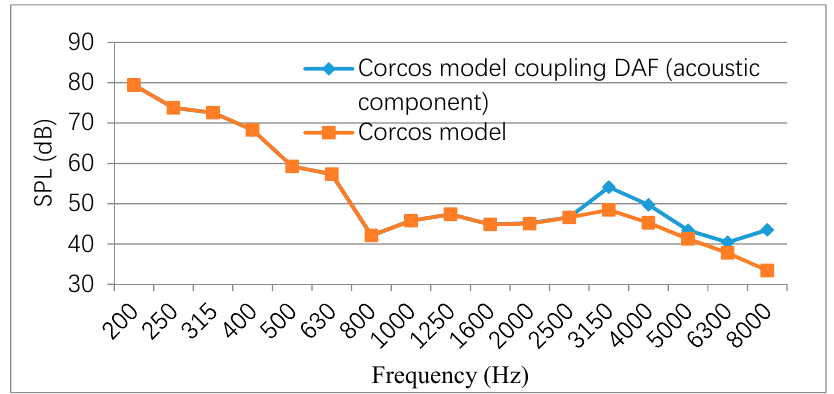
Figure 19. Radiated SPLs of the panel under the Corcos model coupling DAF and only the Corcos model.